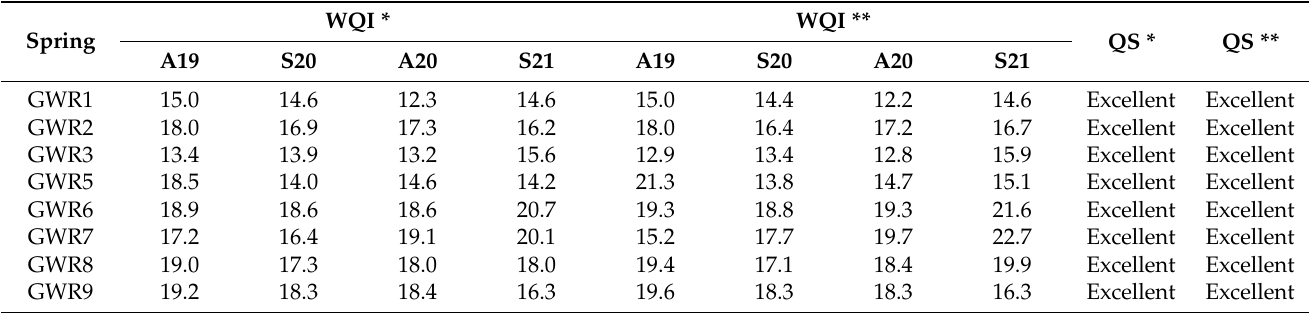
Table 5. Water Quality Index (WQI) and quality status (QS) of the studied karst spring waters calculated using WHO guidelines [19] and Directive 2020/2184 parametric values